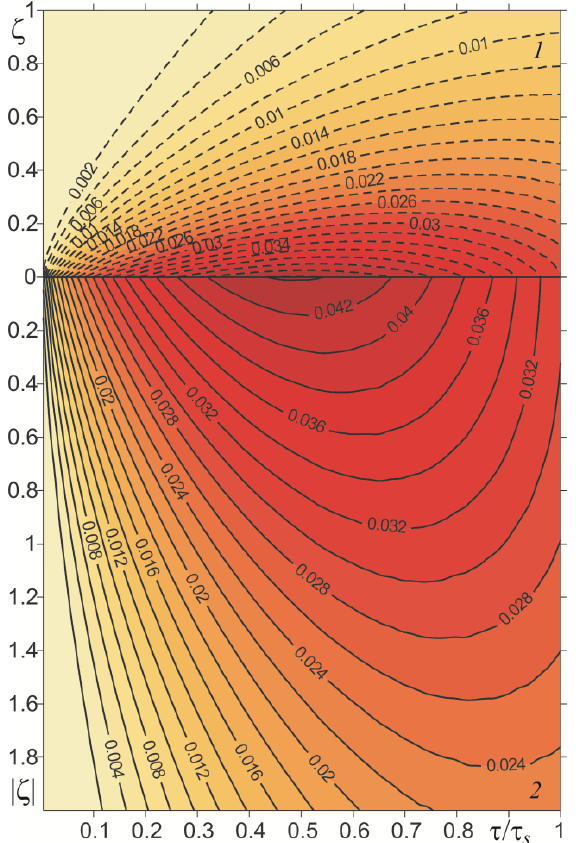
∗ Θ during braking with constant